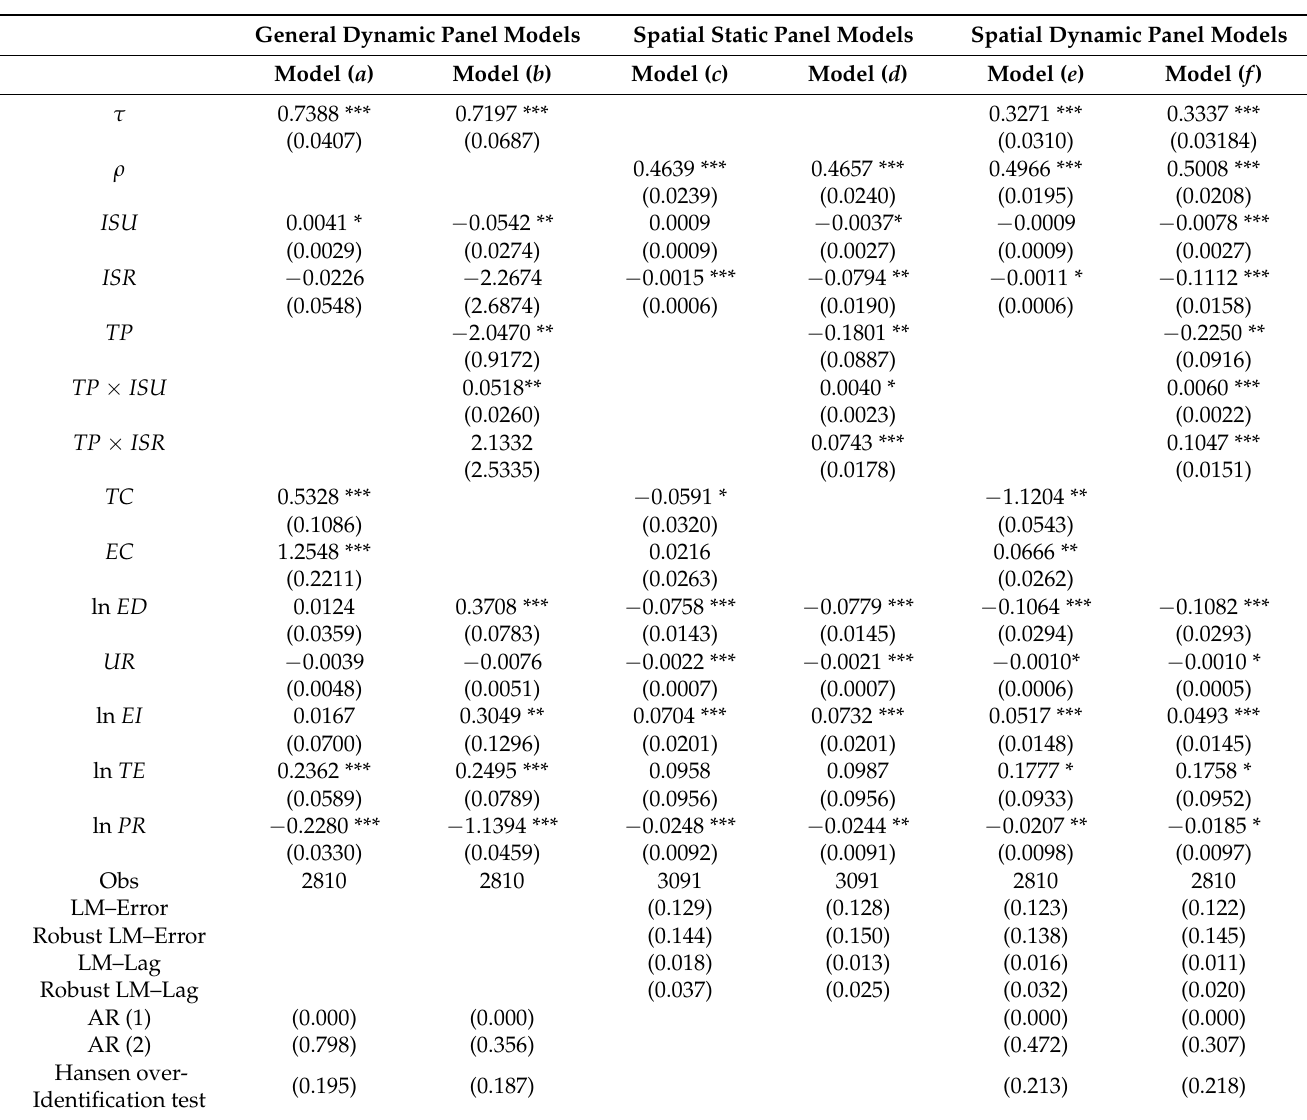
Table 3. Estimation results based on three models. General Dynamic Panel